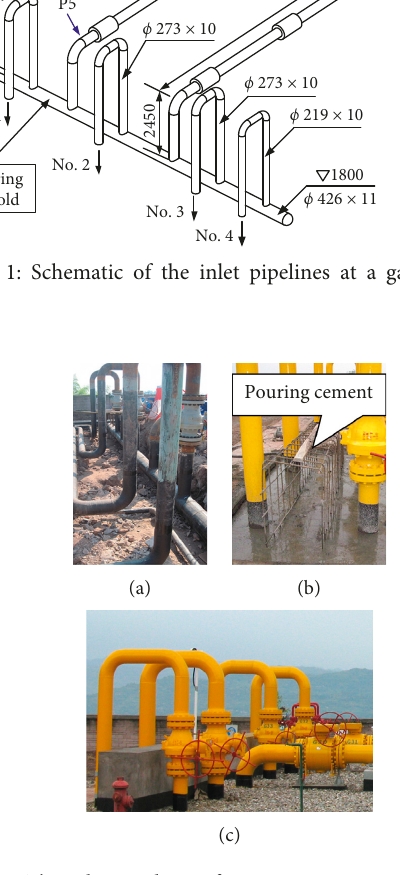
Figure 2: The inlet pipelines after pouring cement and installing supports during